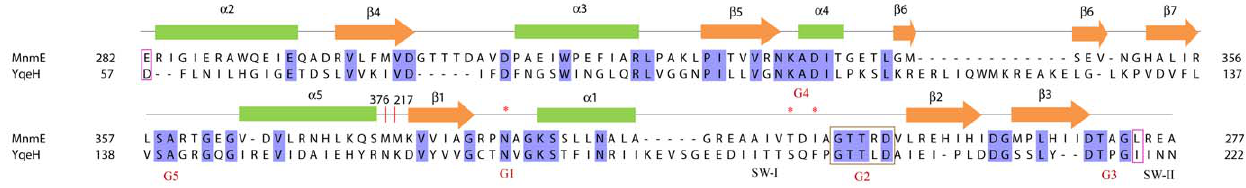
Figure 1. Secondary structure based sequence alignment of the G-domains of MnmE and YqeH. The sequence alignment used to generate the YqeH homology model is shown. Since YqeH is circularly permuted with respect to MnmE, the C-terminal region (282–376 indicated in the figure) of MnmE is relocated to the N-terminus to facilitate alignment with YqeH. a -helices are depicted as green cylinders and b -strands as orange arrows. Sequence motifs G1-G5 are indicated. Conserved residues are highlighted in blue. The catalytic residues in MnmE (E282) and YqeH (D57) are boxed in pink. The hydrophobic substitutions (L274 in MnmE and I219 in YqeH) in place of Q61 of Ras are boxed in pink. Switch-I and II regions are indicated. The conserved motifs in K-loop (GTTRD in MnmE and GTTLD in YqeH) are boxed in brown. Residues that coordinate the potassium ion are indicated by asterisks.